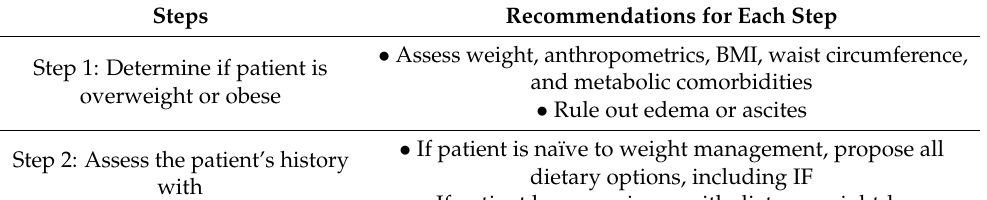
Table 2. Practical recommendations to implement intermittent fasting in patients with